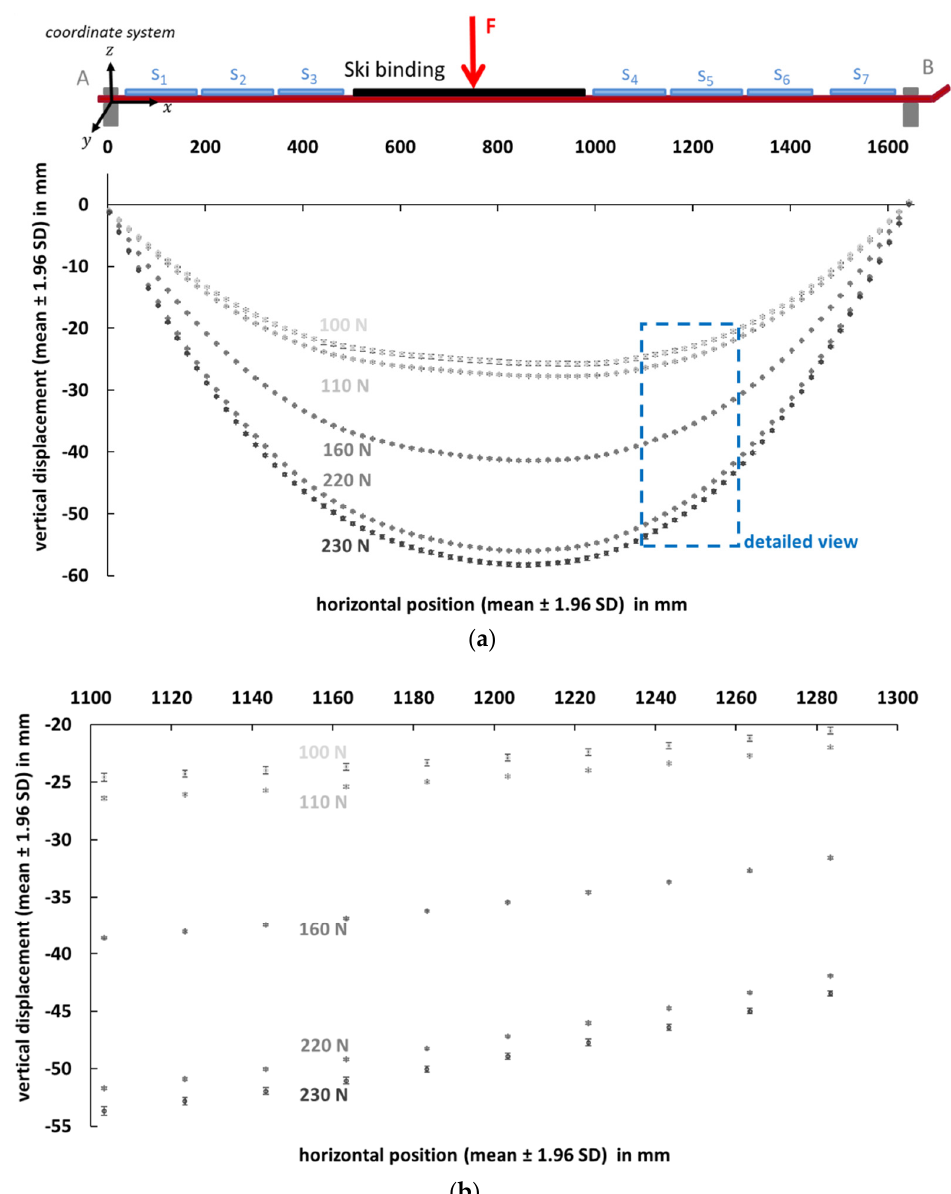
Figure 5. Raw data from the laser measurement system. Vertical displacement (mean ±1.96 SD) vs. horizontal position (mean ±1.96 SD) over three repetitions at different load levels (100 N, 110 N, 160 N, 220 N and 230 N). ( a ) All 83 measuring points; ( b ) Detailed view over 10 measuring points. Table 1. Analysis of instrument reliability from the sensor